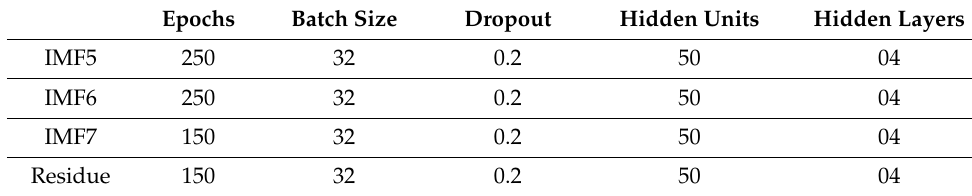
Table 9. Hyper-parameters of SEMD-LSTM model. Epochs